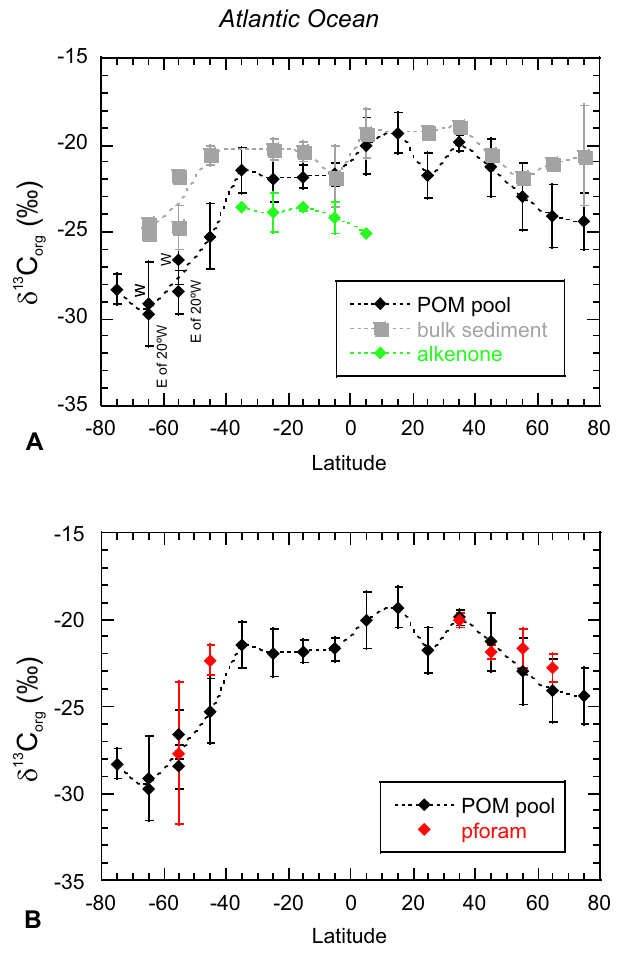
Fig.2|Atlanticlatitudinaltransects.A Averagedtransects(10°latitudeboxes)of δ 13 C δ 13 C. Black diamonds show org-POM , 13 C org of bulk sediments and alkenone organic carbon isotopes of particulate organic matter (POM), grey boxes 13 C org of bulksediments,andgreendiamondsalkenone δ 13 C.Meansandstandarddeviations were calculated for sample sizes of 2 and above. On average, n =14 for δ 13 C org-POM , for 13 C org of bulk sediments n is 4 on average, and 6 for alkenone δ 13 C. Latitudes between 60 – 70° S and 50 – 60° S are split in an eastern and western section at 20° longitude for POM. B Averaged transects (10° latitude boxes) of δ 13 C org-POM and δ 13 C org-pforam . Black diamonds show organic carbon isotopes of particulate organic matter (POM), whereas red diamonds show δ 13 C org-pforam . Like in A , standard deviations are calculated for an n =14 on average for δ 13 C org-POM , and 3 for δ 13 C org-pforam